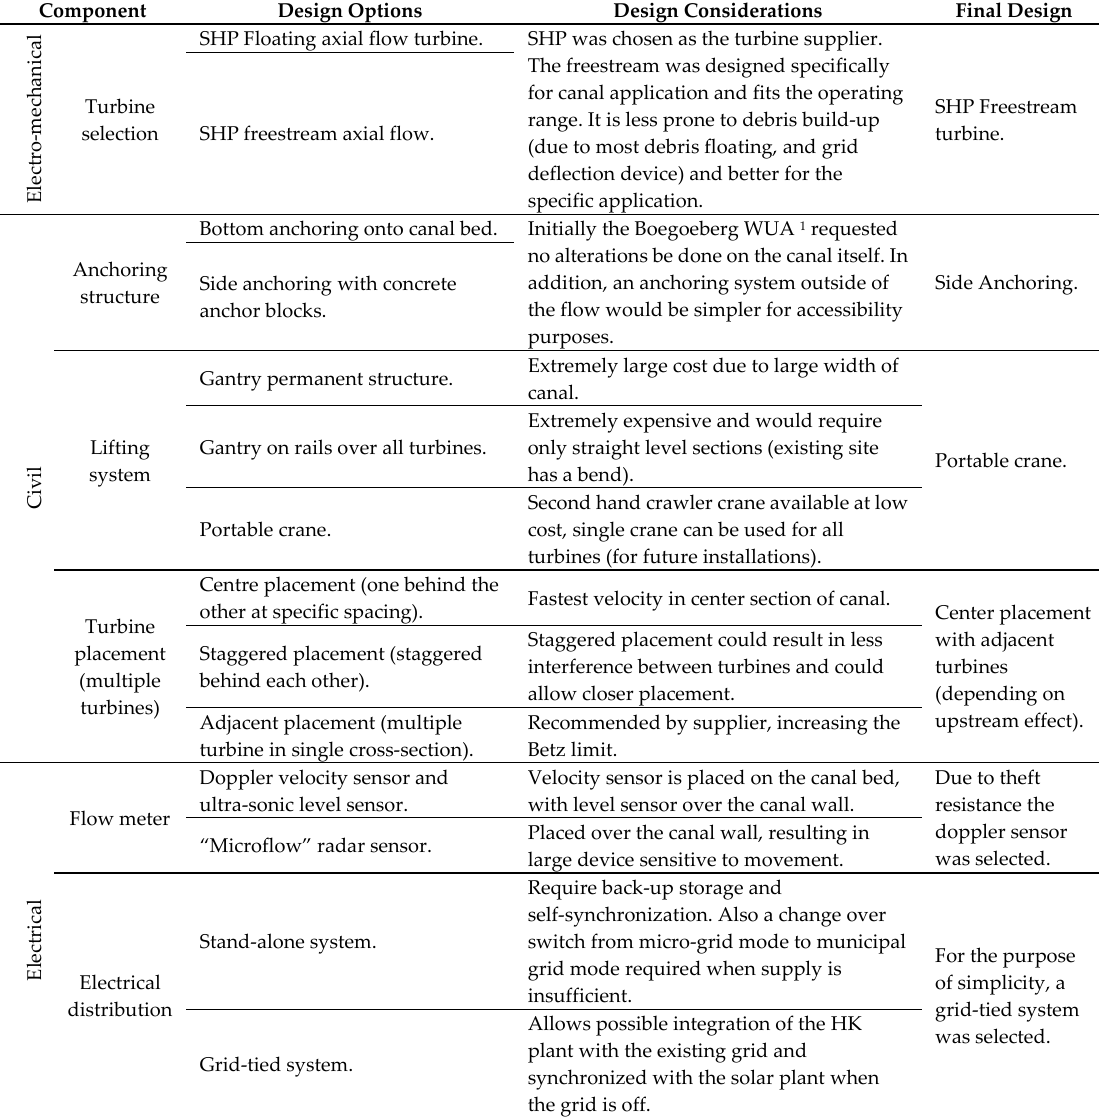
Table 1. Design Considerations.